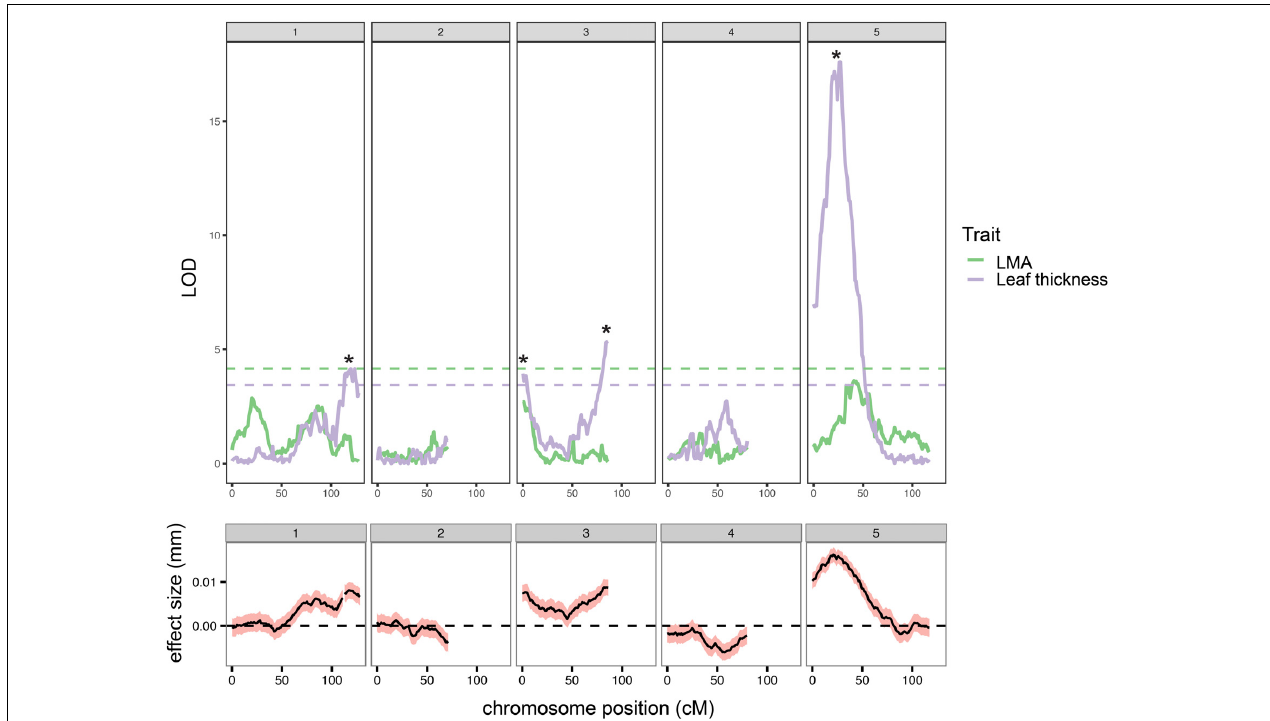
FIGURE 1 | Quantitative trait loci (QTL) for leaf thickness (purple) and leaf mass per area (LMA, green) were identified using the Ler × Cvi RILs. LOD scores resulting from the scanone function in R/qtl are plotted for each trait (top). LOD significance thresholds (based on 10,000 iterations) are plotted as horizontal dashed lines. Significant leaf thickness peaks are marked with asterisks. Estimated effect size (mm leaf thickness) and associated standard error are shown in